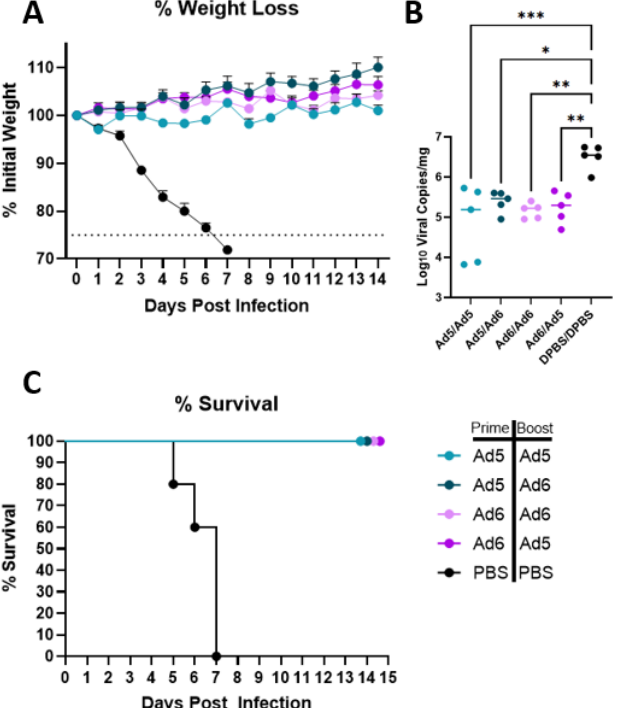
Figure 4. Protection against challenge with a lethal human H2 isolate. BALB/c mice ( n = 10) were vaccinated with 10 10 vp of Ad5-H2-Con, Ad6-H2-Con, or PBS and boosted with either homologous or heterologous vaccine regimen. Mice were challenged with 20MLD 50 of A/Korea/426/1968, then monitored for morbidity ( A ), clearance of viral RNA from the lungs ( B ), and mortality ( C ). Mice that lost 25% of their initial weight were humanely euthanized ( n = 5; one-way ANOVA with Tukey multiple comparison; * p < 0.05, ** p < 0.01, *** p < 0.005).